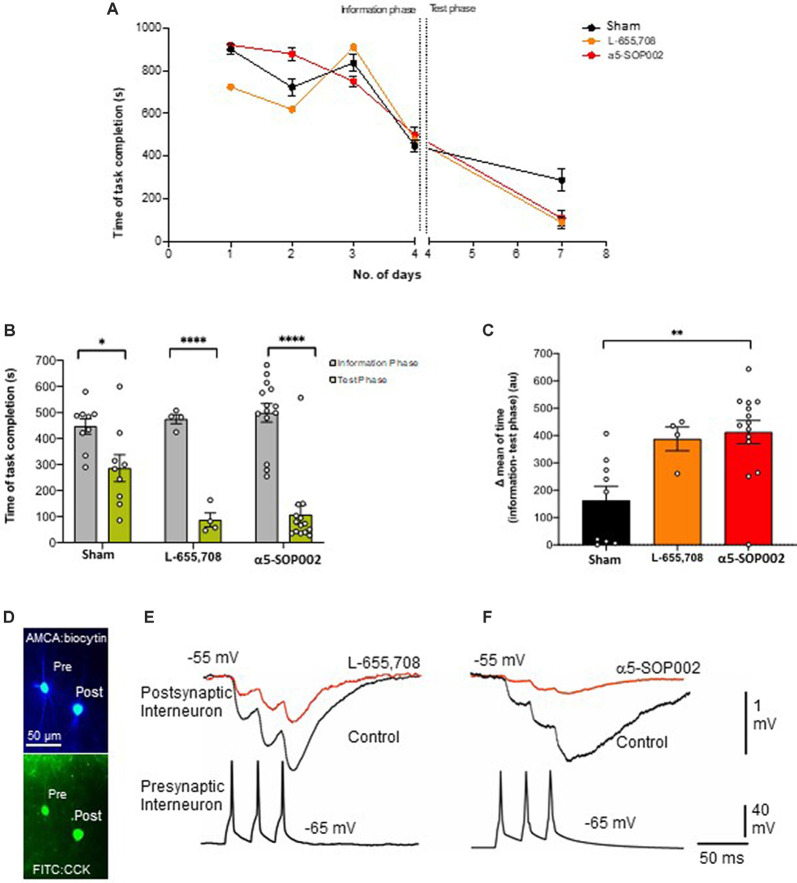
α5-SOP002 improved memory in healthy rats performing the eight-arm radial arm maze (RAM) test, consistent with the NAM effect shown by in vitro electrophysiological recordings. (A–C) Analysis of RAM test performed in healthy rats treated with “sham,” α5-SOP002- and L-655, 708. (A) Illustration of the variability of time taken to complete the memory task between all groups during 7 days (training + test phases). (B) Bar graphs compare the time taken to complete the tasks during training day 4 (defined as the information phase; gray) and day 7 (defined as test phase; green) for all groups tested. The time to complete the task during the test phase after administration of either; α5-SOP002 and L-655, 708, was reduced compared to control, suggesting potentiation of spatial memory recall. (C) Bar graphs representing the difference in mean time taken to complete the task between the information and test phase of each group. The a5-SOP002-treated rats had a statistically significant difference while both α5-SOP002- and L-655, 708-treated groups showed a bigger difference compared to the sham group. Results are expressed as mean ± standard error of the mean (SEM; black; sham group, n = 9, orange; L-6, 55 n = 4 and red; a5-SOP002 n = 14; one-way ANOVA, *P < 0.05, **P < 0.01, ****P < 0.0001). (D) Representative images of the anatomy of dendrite targeting, presynaptic CCK schaffer collateral-associated (SCA) cells synaptically connected to a postsynaptic CCK cell (AMCA shows the biocytin labeling during electrophysiological recordings). (E,F) Paired recording, trains of presynaptic action potentials elicited unitary inhibitory postsynaptic potentials (IPSPs), that were reduced by both NAMs selective for a5 GABAA receptors, L-655, 708 and α5SOP002.